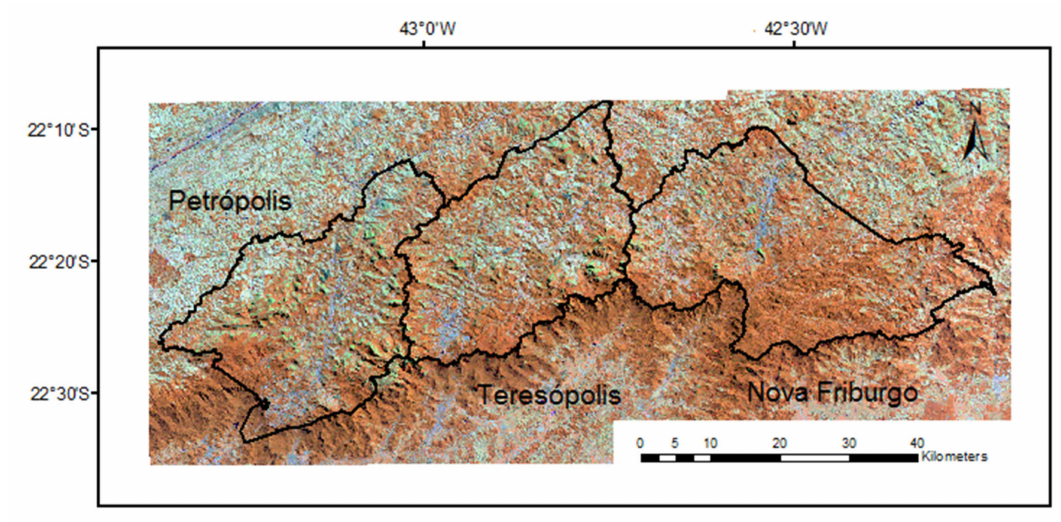
Figure 4. Landsat images used for the classification process (orbit 216, scenes 075 and 076 (09 / 04 / 2011) and orbit 217, scenes 075 and 076 (08 / 28 / 2011)). color composition rgb